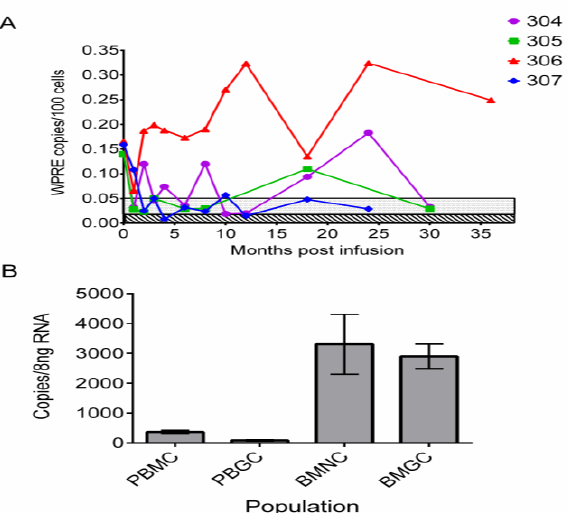
Figure 1. Sustained engraftment and expression of anti-HIV genes in the peripheral blood of patients for up to three years after transplantation. ( A ) Level of gene marking expressed as number of copies of vector (WPRE) per 100 blood cells analyzed over time. Unique patient identifiers are listed in the upper right hand corner of graph. Limits of quantification (stippled) and limits of detection (diagonal lines) values were determined for each amplification reaction and typically were in the range of 0.05% (500 cells/million) and 0.01% (100 cells/million), respectively. ( B ) Expression of shRNA against tat/rev sequences in the blood and marrow of UPN0306 at 36 months. Results expressed as copies of shRNA per 8 ng of total RNA. PBMC—peripheral blood mononuclear